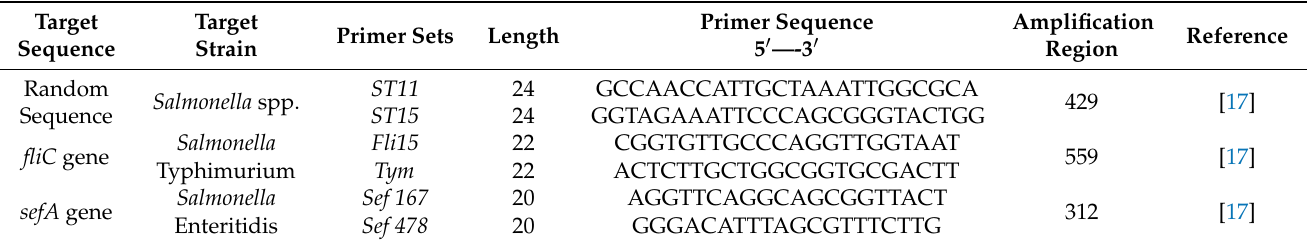
Table 1. Primers used for Salmonella detection with Multiplex